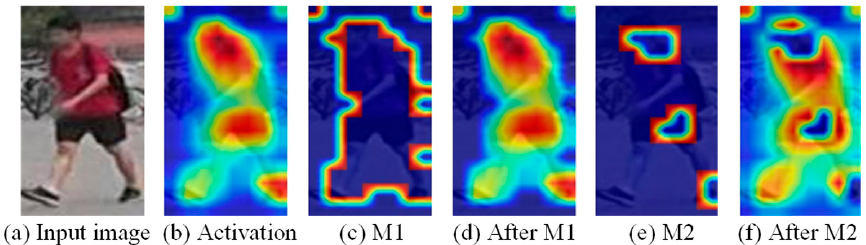
Figure 5. Activation maps, the background mask M1 and the maximum activation mask M2 of the input image, and the effects after M1 , M2